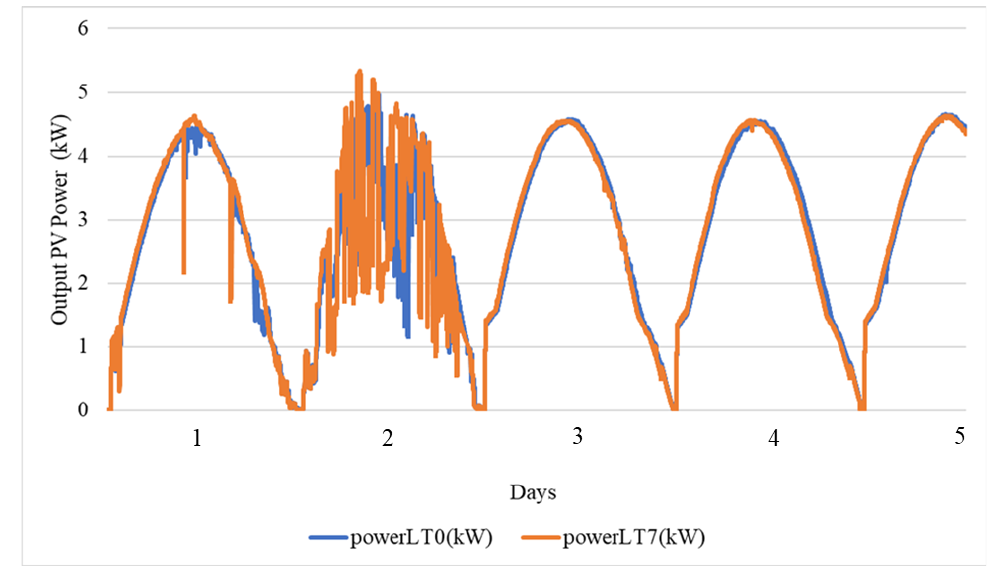
Figure 10. Sample PF PV power output.